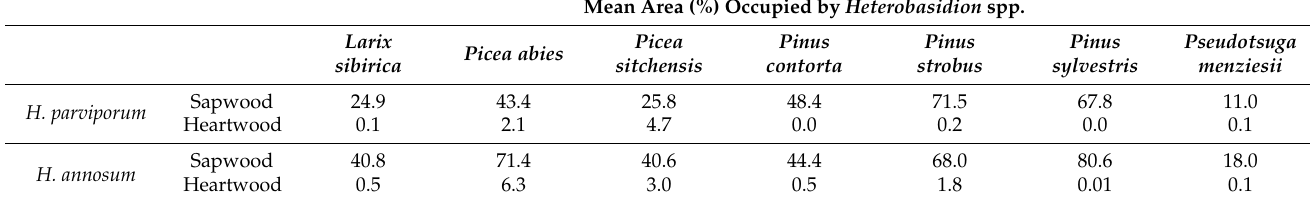
Table 2. The percentage of the area occupied by Heterobasidion annosum and H. parviporum in the sapwood and heartwood of the discs of seven tree species. Mean Area (%) Occupied by Heterobasidion spp. Larix sibirica